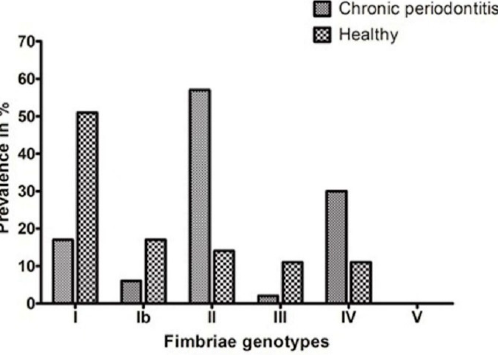
Figure 2. Bar chart showing the frequency distribution of fimA genotypes in subjects detected positive for P. gingivalis in the chronic periodontitis and healthy groups.